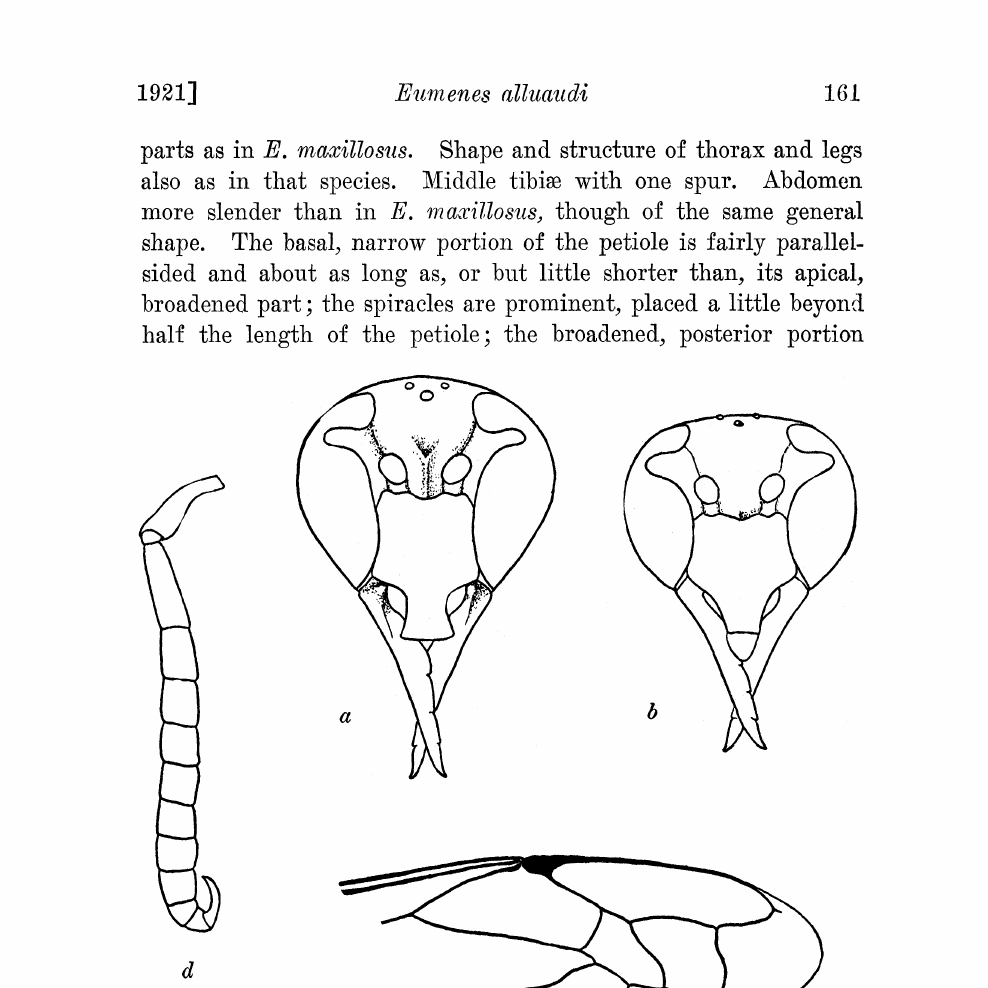
, Fig. 1. !iumenes aliuaudi J. :Prez. a, head of male in front view; b, head part of fore wing; d, anten of male. of female in front view; is nearly parallel-sided, but it has expanded apical angles as iI1 E.